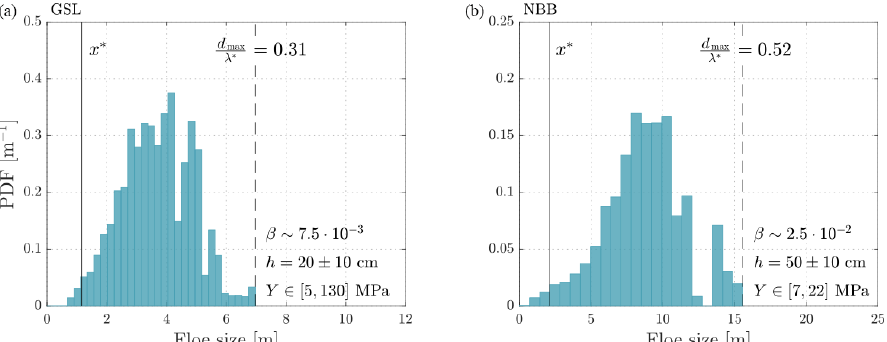
Figure 10. Area-based floe size distributions (AFSDs) resulting from the breakup experiments computed with Eq. (3). The maximal floe size is compared to λ ∗ , the incident wavelength of the highest-amplitude ship-generated wave estimated using Eq. (1), and to x ∗ , the flexural rigidity length scale given by Eq. (10) with values of Y derived from Tkacheva